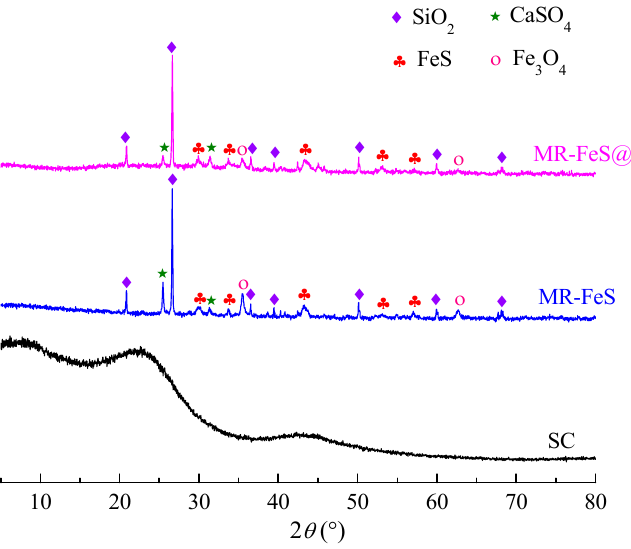
Figure 2. XRD patterns of SC, MR – FeS, and MR – FeS@SC.